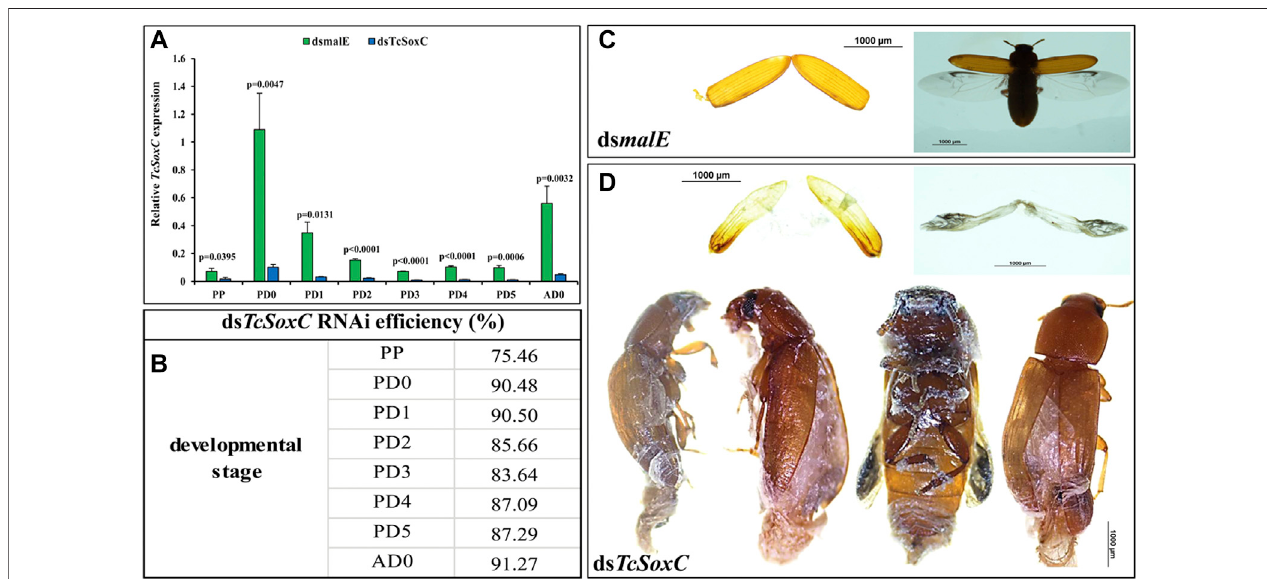
FIGURE 2 | RNAi ef fi ciency and phenotypes of TcSoxC knockdown in T. castaneum . 400 ng of ds SoxC was injected into each larva on the dorsal side of the abdomen. Control larvae were injected with ds RNA targeting E. coli malE gene. (A) The expression of TcSoxC decreased signi fi cantly after TcSoxC knockdown at different developmental stages. (B) The RNAi ef fi ciency of Tc-SoxC knockdown ranged from 75.46% (PP) to 91.27% (AD0). (C) The phenotypes of ds malE injected insects. (D) The phenotypes of ds SoxC injected insects. The tanning as well as the expansion of forewings (elytra) and hindwings (membranous wings) were abnormal in ds SoxC treated insects. Four randomly selected insects were injected with ds TcSoxC , leading to incomplete molting and shedding of the pupal cuticle. Means ± SE of three independent experiments are shown ( p values comes from t tests ). PP: pre-pupa, PD0: newly molted pupa (0 h after ecdysis into the pupal stage), PD1: 24 h after ecdysis into the pupal stage, PD2: 48 h after ecdysis into the pupal stage, PD3: 72 h after ecdysis into the pupal stage, PD4: 96 h after ecdysis into the pupal stage, PD5: 120 h after ecdysis into the pupal stage, AD0: newly eclosed adult. (For interpretations of color reference in this fi gure legend, the reader is referred to the Web version of this